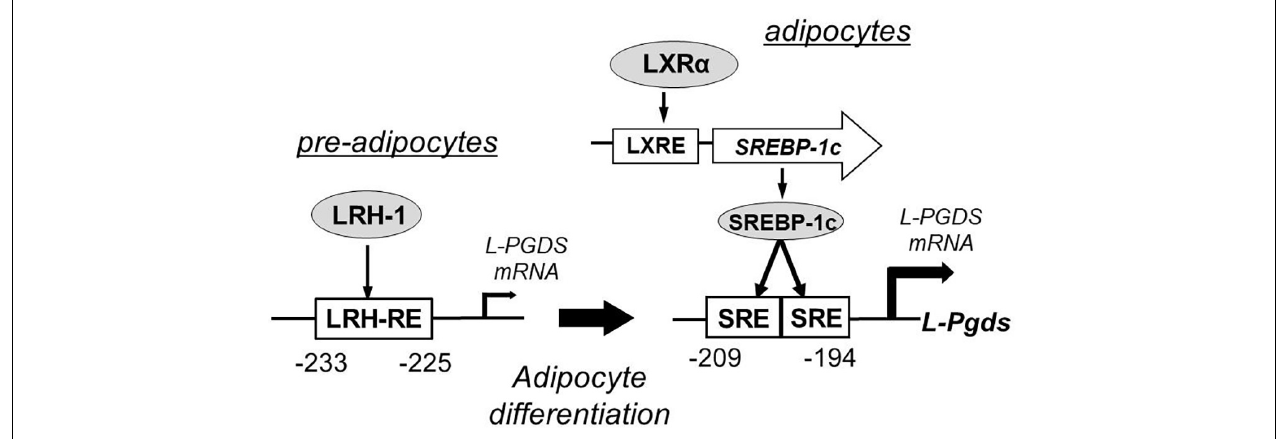
FIGURE 7 | Transcriptional regulation of mouse L-Pgds gene in adipocyte 3T3-L1 cells (Fujimori et al., 2007a). L-Pgds gene expression is activated by liver receptor homolog-1 (LRH-1), one of orphan nuclear receptors, through the LRH-responsive element (LRH-RE) in pre-adipocytes. In the differentiated adipocytes, activation of liver X receptor (LXR) elevates the expression of sterol regulatory element-binding protein-1 (SREBP-1c) through the LXR-responsive element (LXRE), and then SREBP-1c strongly enhances the L-Pgds gene expression via two sterol regulatory elements (SREs) in the promoter region of L-Pgds